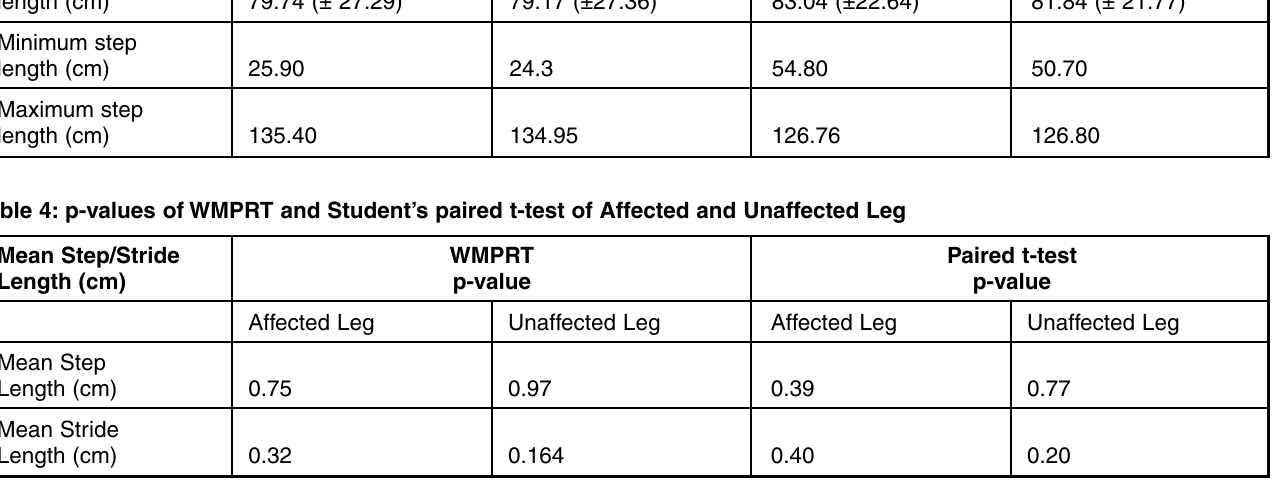
Table 3: Stride length with and without FECK brace Stride Length (cm)